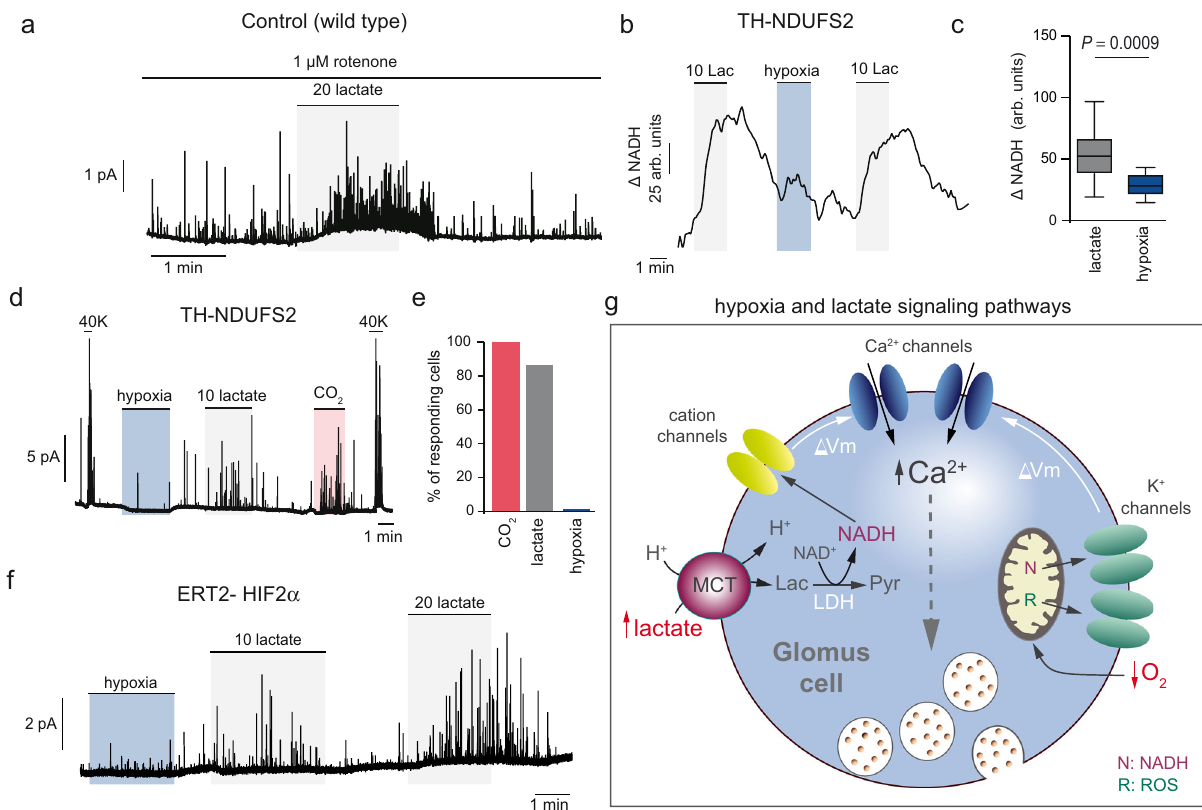
Fig. 6 Separate lactate- and O 2 -sensing mechanisms in glomus cells. a Amperometric recording illustrating the secretory response to lactate (20 mM, gray) in the presence of rotenone (1 μ M). Similar recordings were obtained in 7 cells from 3 mice. b , c NADH signals induced by lactate (Lac, 10 mM; gray) in a hypoxia (Hx, O 2 tension ≈ 15 mm Hg; pale blue)-insensitive glomus cell dispersed from a Ndufs2-de fi cient CB. Box plots representing the distribution of changes in NADH signals ( Δ NADH) in 22 cells from 3 mice exposed to the two stimuli. In these experiments, all cells responded to lactate (10 mM) but only 40% of the cells showed some responsiveness to hypoxia (O 2 tension ≈ 15 mm Hg). Mean ± SEM values are: 10 mM lactate: 52.5 ± 4.3; hypoxia: 28.2 ± 3.2. P value calculated by two tails, unpaired t test is indicated. The boxplot represents the median (middle line), 25th, 75th percentile (box), and largest and smallest values extending no further than 1.5 × interquartile range (whiskers). Source data are provided as a Source data fi le. d , e